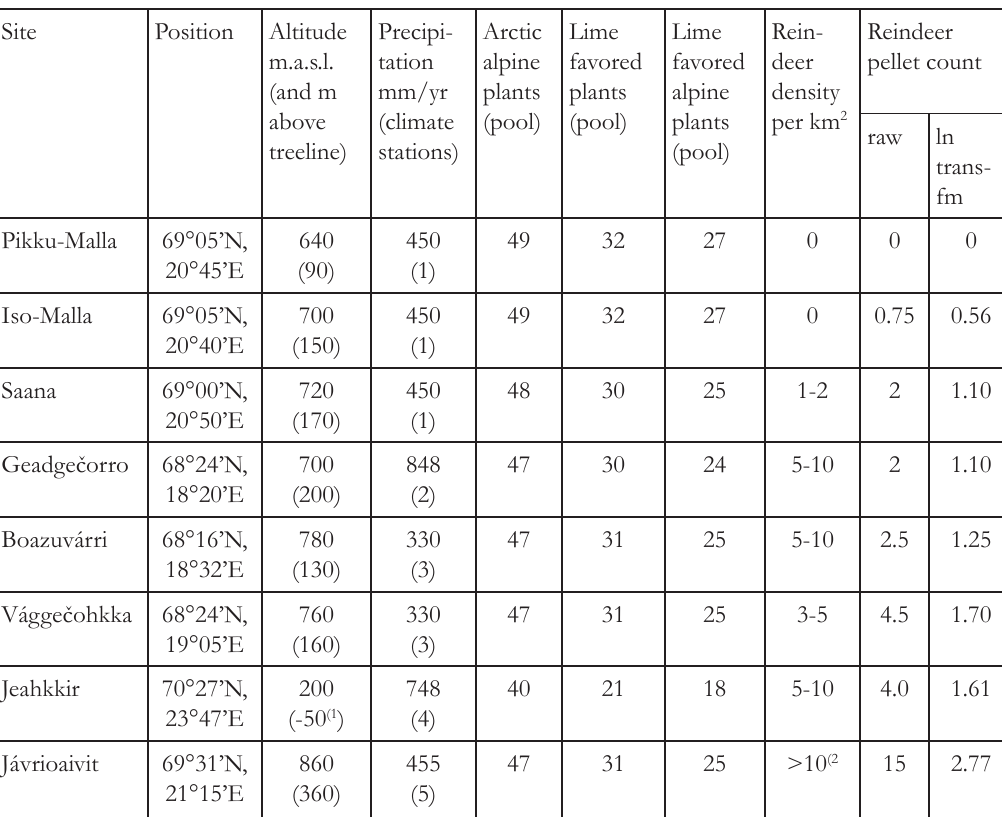
Table 1. Position, altitude, precipitation (climate stations: 1 = Kilpisjärvi, 2 = Katterjokk, 3 = Abisko, 4 = Ankerlien, 5 = Porsa Gruber), number of arctic-alpine and lime favoured phanerogams species in the Atlas Florae Europae (Jalas et al ., 1972-99) grid to which the site belongs within the taxa for which the Atlas work has been completed, and reindeer grazing pressure in accordance to official statistics (reindeer per km 2 , Bernes, 1996) and reindeer pellet counts. The reindeer densities of Jávrioarvit are adjusted for the real size of the summer range and are thus different to the number presented by Bernes